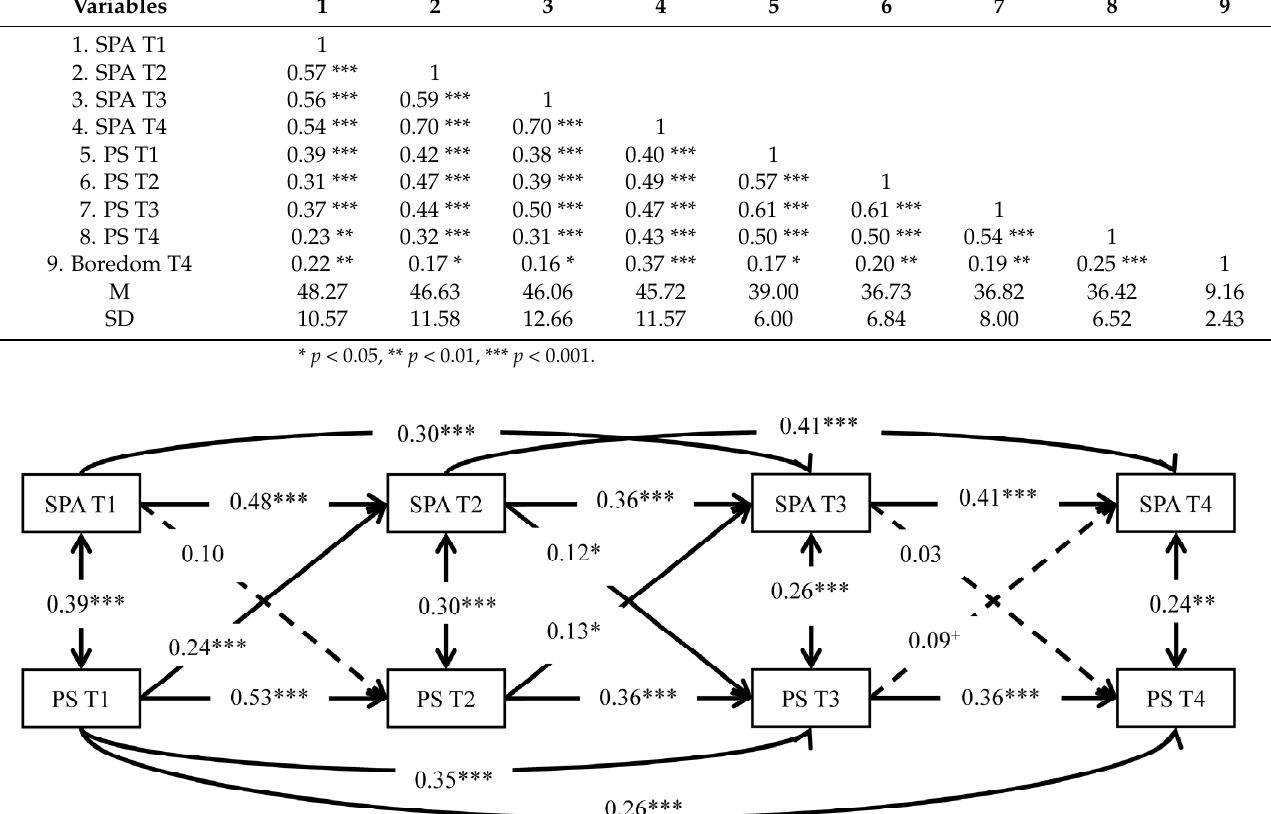
with standardized path coefficients ( β ). Note: Dashed lines indicate non-significant paths. N = 197.